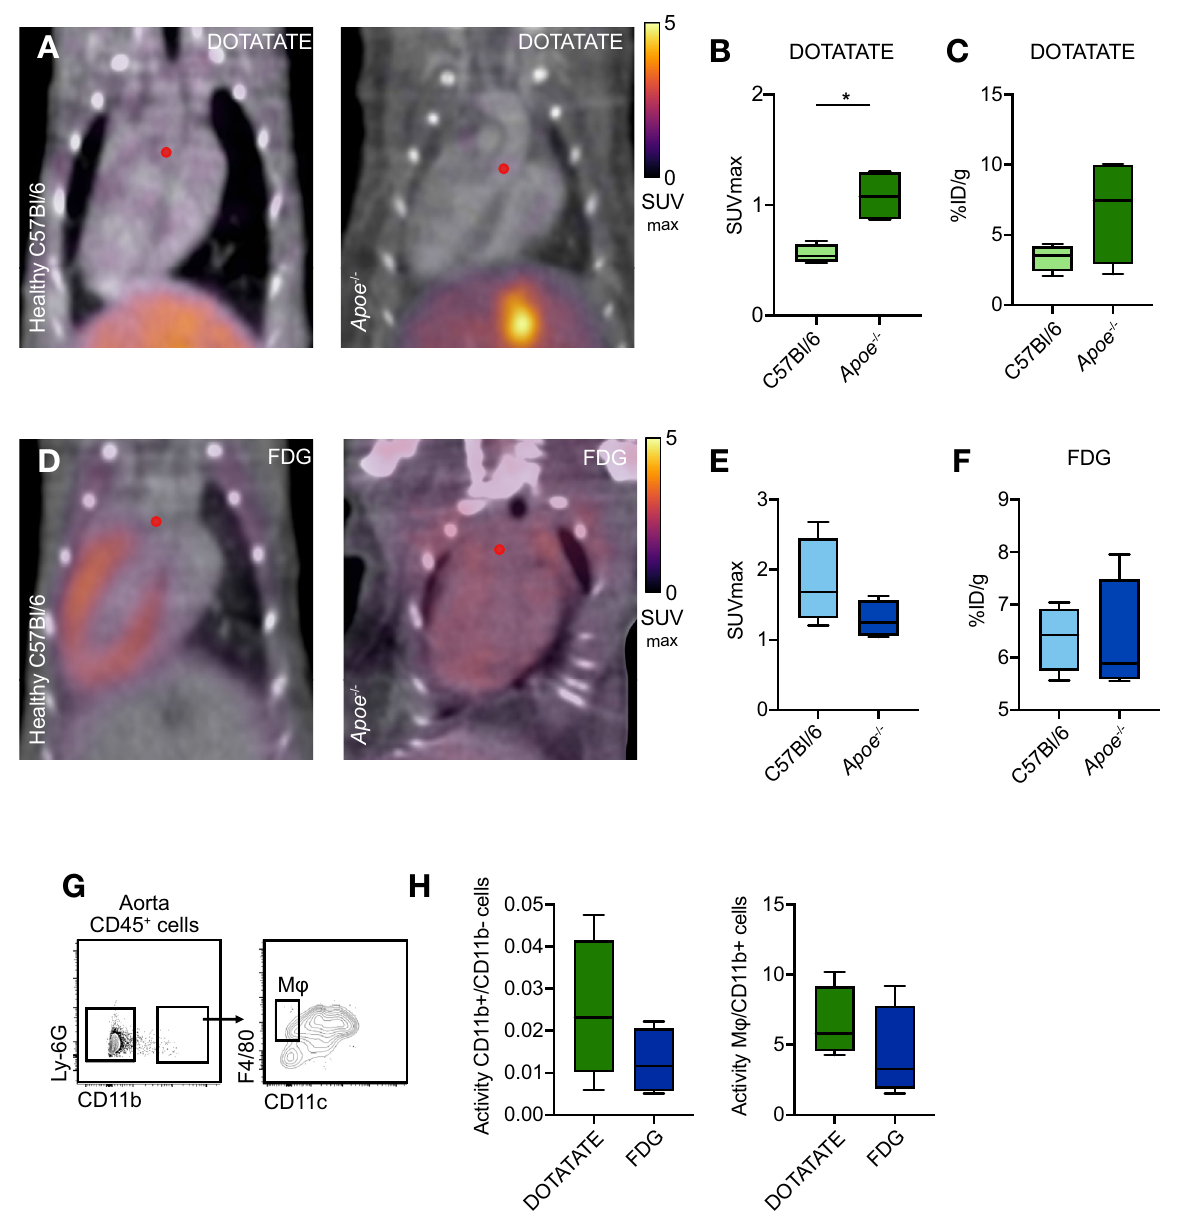
Figure 4. [ 64 Cu]Cu-DOTATATE PET imaging of murine atherosclerosis. ( A ) Representative fused PET/CT image of [ 64 Cu]Cu-DOTATATE-infused C57Bl/6 (left) and Apoe −/− mice after 12 weeks on WD (right). Red dot represents origin of ascending aorta. ( B ) In vivo [ 64 Cu]Cu-DOTATATE SUV max of the ascending aorta. N = 4 per group. ( C ) Ex vivo %ID/g of the whole aorta. N = 4 per group. ( D ) Representative fused PET/CT 3D-rendered image of [ 18 F]F-FDG-infused Apoe −/− mice. Red dot represents origin of ascending aorta. ( E ) [ 18 F]F-FDG SUV max of ascending aorta. N = 4 per group. ( F ) %ID/g of the whole aorta. N = 4 per group. ( G ) Representative flow cytometry plots identifying CD11b + and macrophage cell populations in the aorta. ( H ) Quantification of activity per cell in the aorta. Data are expressed as ratio of CD11b + /CD11b − (left) and Mφ/CD11b + cell activity (right). N = 4 per group. DOTATATE: [ 64 Cu]Cu-DOTATATE; FDG: [ 18 F]F-FDG; ID: injected dose; Mφ: macrophages; SUV max : maximum standardized uptake value. CD11b + cells represent CD11b + CD11c hi , excluding macrophage population. * p < 0.05. Data are presented as median (interquartile